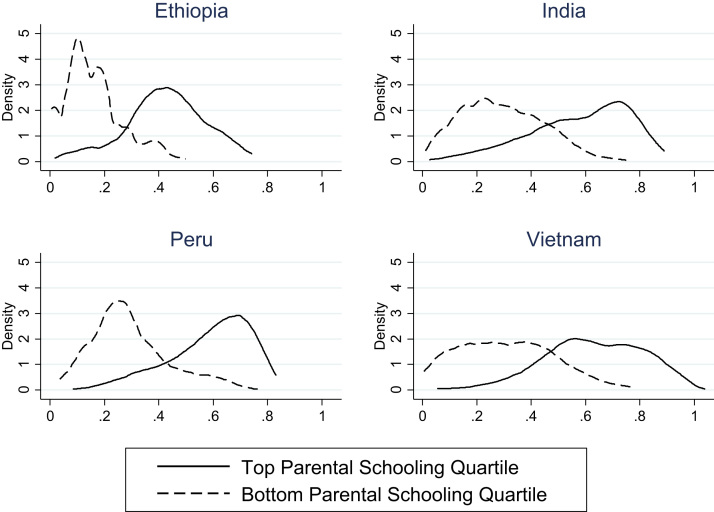
Densities of Wealth Index by Average Parental Schooling.